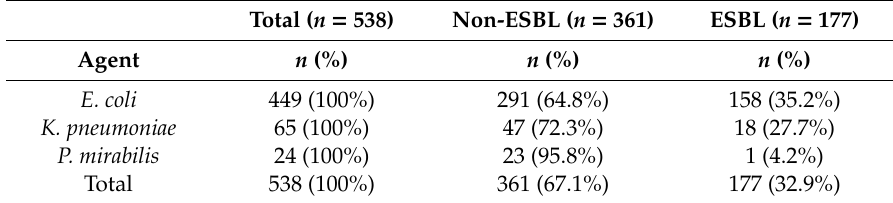
Table 1. Prevalence of ESBL among the three common uropathogens.